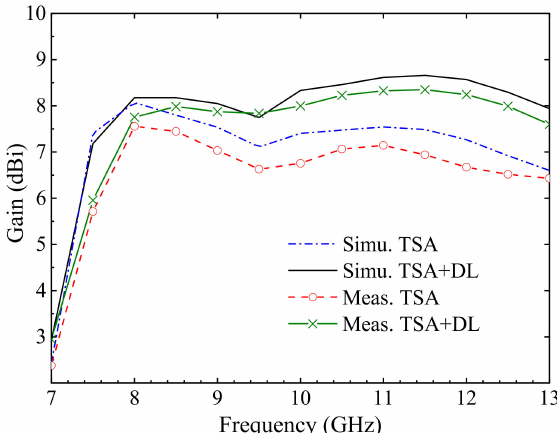
Figure 10. Measured and simulated gain of the designed antipodal tapered slot antenna (TSA), and comparison of two different antenna structures with and without